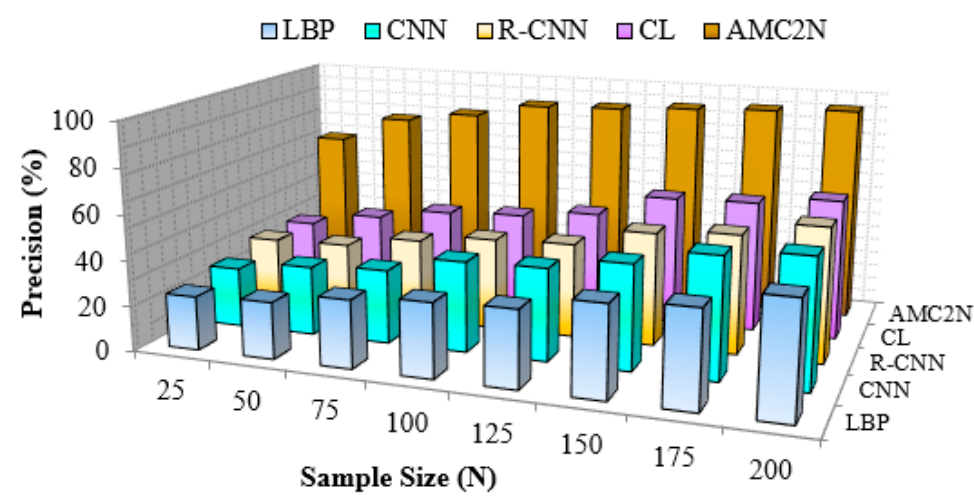
Figure 14. Comparison of precision (Scenario 2).